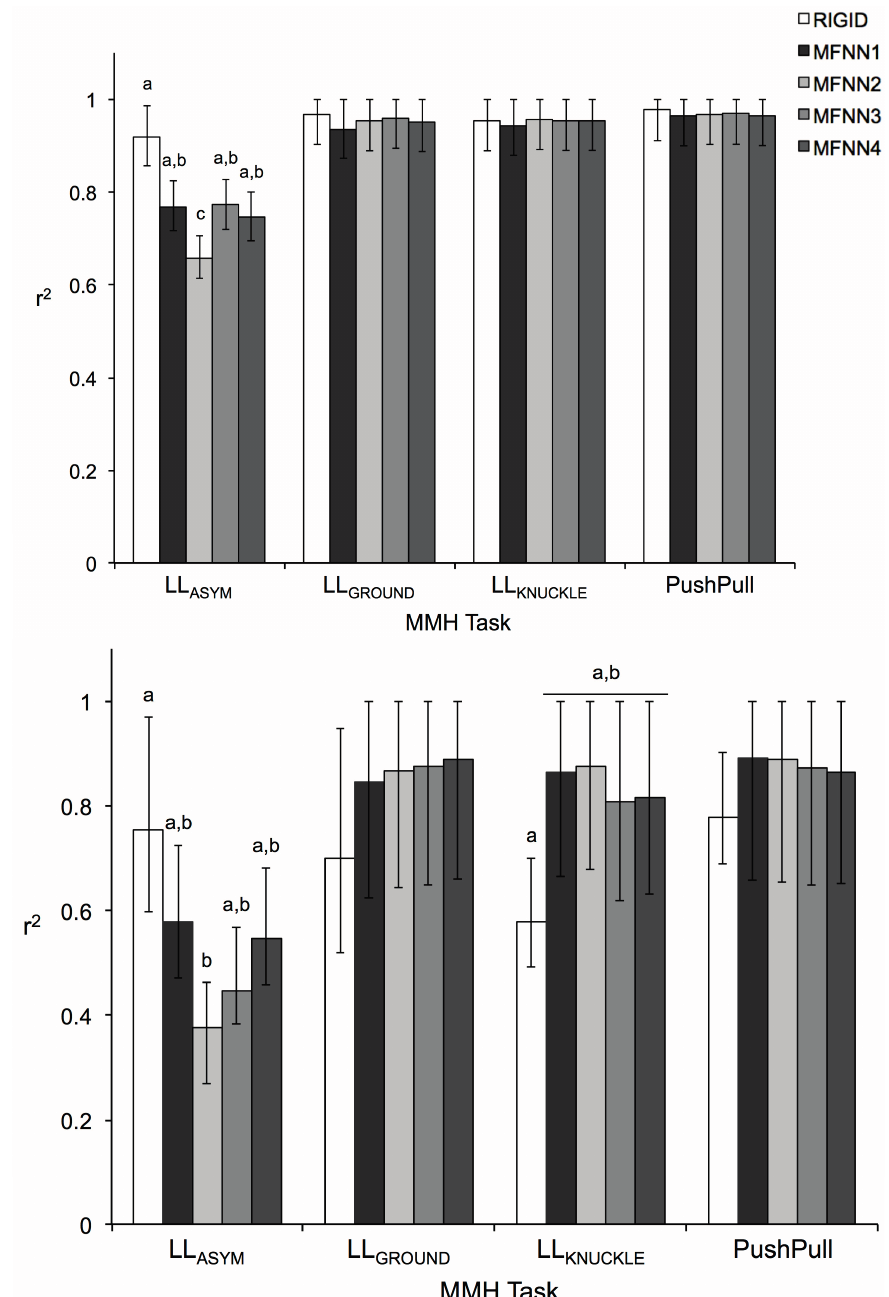
Figure 4. Coefficients of determination (r 2 ) in the AP ( Top ) and the ML ( Bottom ) directions for each MMH task type with respect to the different methods for (cid:1794) (cid:2893)(cid:2924)(cid:2929)(cid:2925)(cid:2922)(cid:2915)(cid:2903)(cid:2918)(cid:2925)(cid:2915) . Pairs of values with different letters are significantly different within a given MMH task type, and error bars indicate 95% confidence